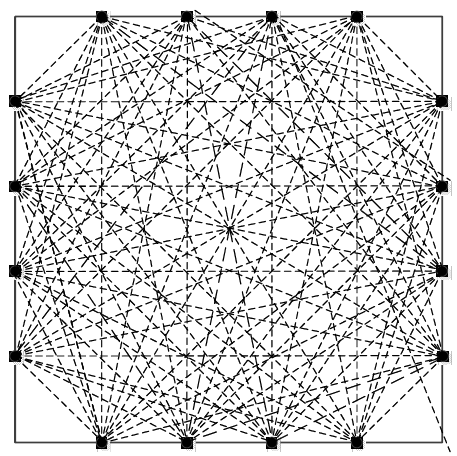
Figure 9. The layout of piezoelectric sensor network.